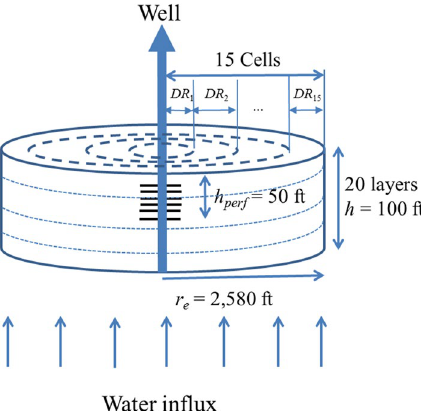
Fig. 17 General view of base fine-grid radial simulation model for sensitivity study